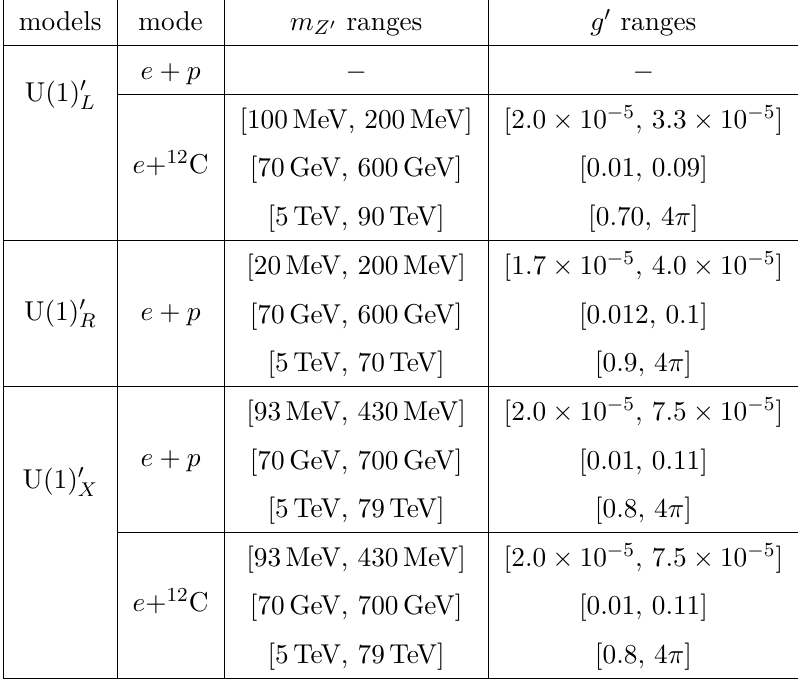
in the e + p mode are void L